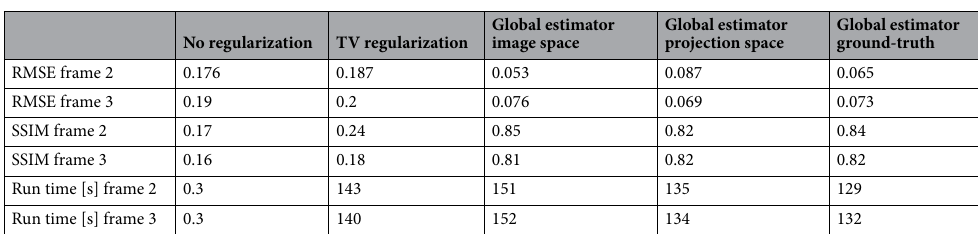
Table 2. Summary of results of simulations for global-estimator with accelerating image.